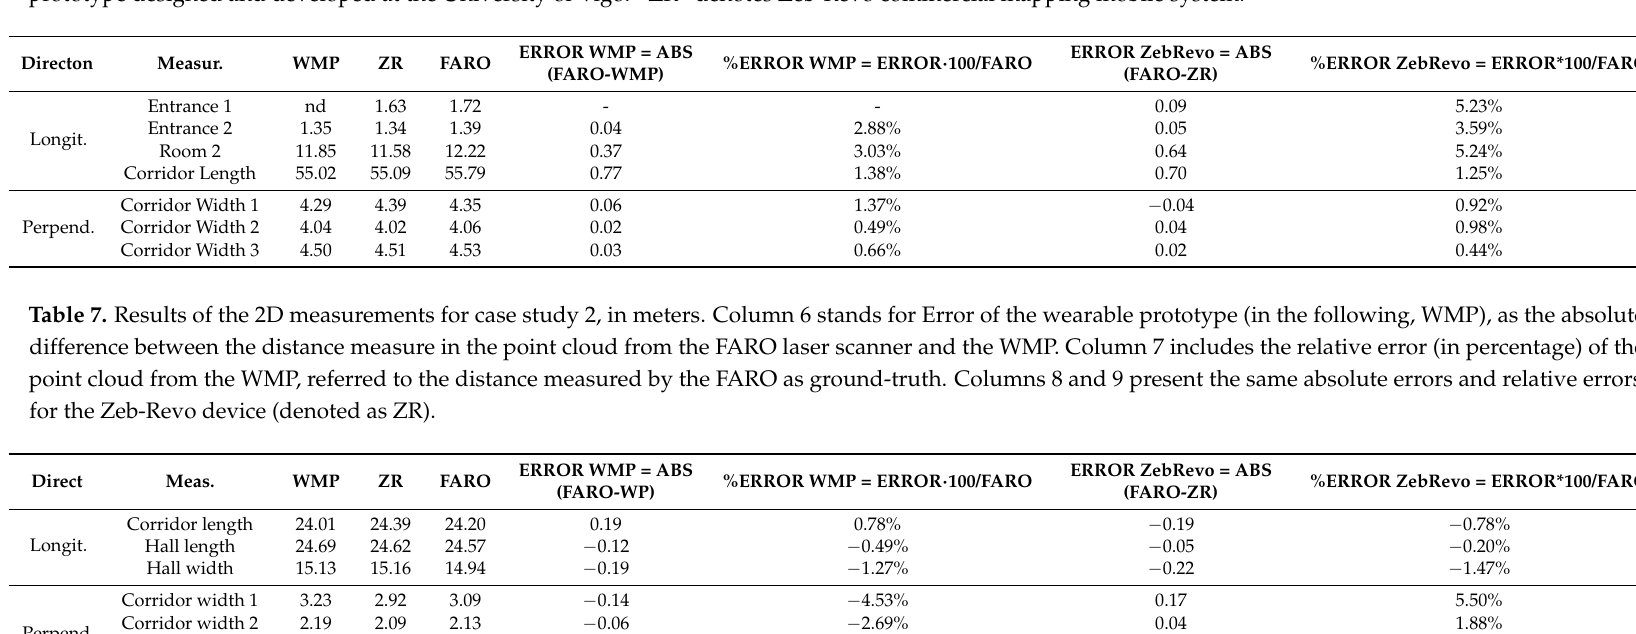
ERROR ZebRevo = ABS (FARO-ZR)